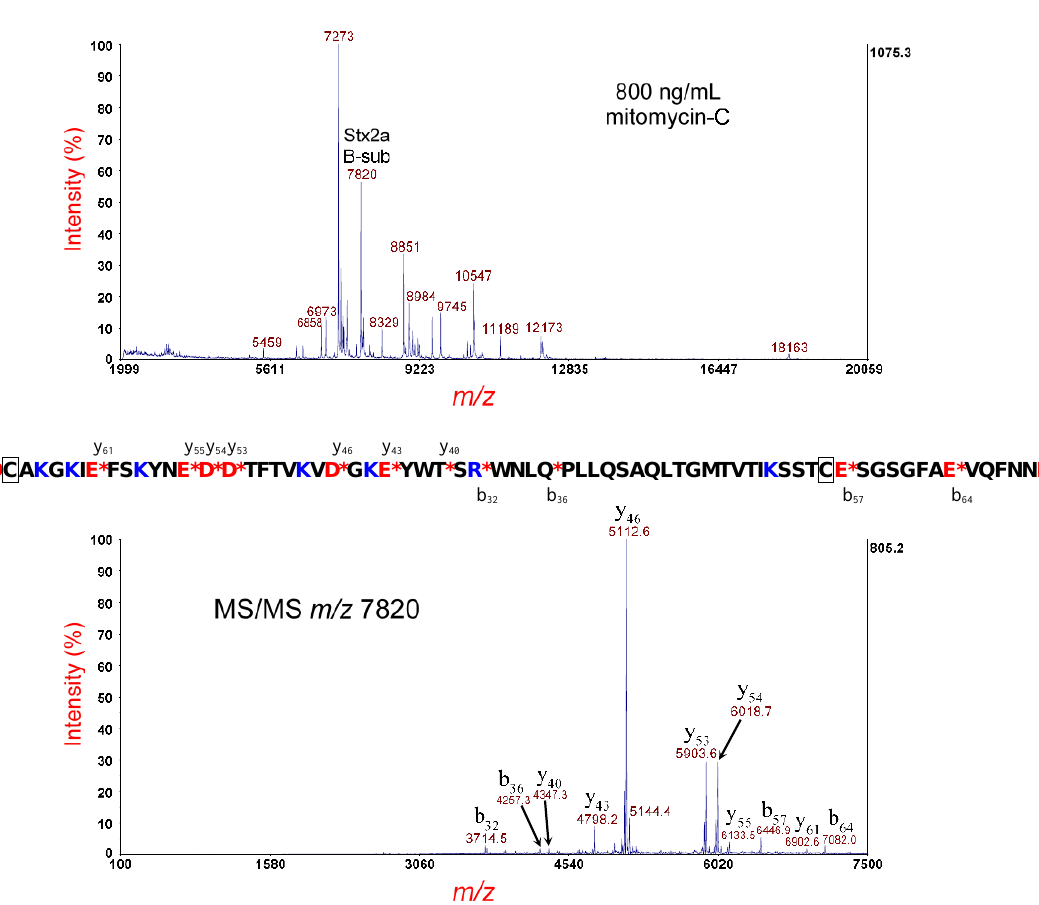
Figure 4. Top panel: MS analysis of E. coli O145:H28 strain RM12367-C1 cultured overnight on LBA supplemented with 800 ng / mL of mitomycin-C and disulfide-reduced. The putative disulfide-reduced B-subunit of Stx2a is indicated. Bottom panel: MS / MS analysis of the putative B-subunit at m / z 7820 in the top panel. Fragment ions are indicated by their m / z and b- or y-type designations. The sequence of the Stx2a B-subunit is shown. A red asterisk indicates sites of polypeptide backbone cleavage that generate the corresponding fragment ions shown above (y-type) or below (b-type) the sequence. Acidic residues are highlighted in red and basic residues in blue. Cysteine residues are boxed.